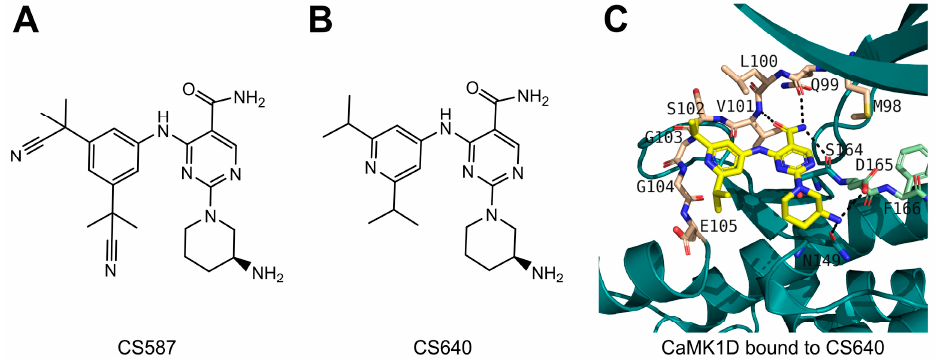
Figure 2. Structures and binding of CaMK1D inhibitors. ( A ) Structure of CS587. ( B ) Structure of CS640. ( C ) CS640 bound to CaMK1D in the ATP binding pocket. The P-loop has been made transparent for better visibility. Adapted from [28].